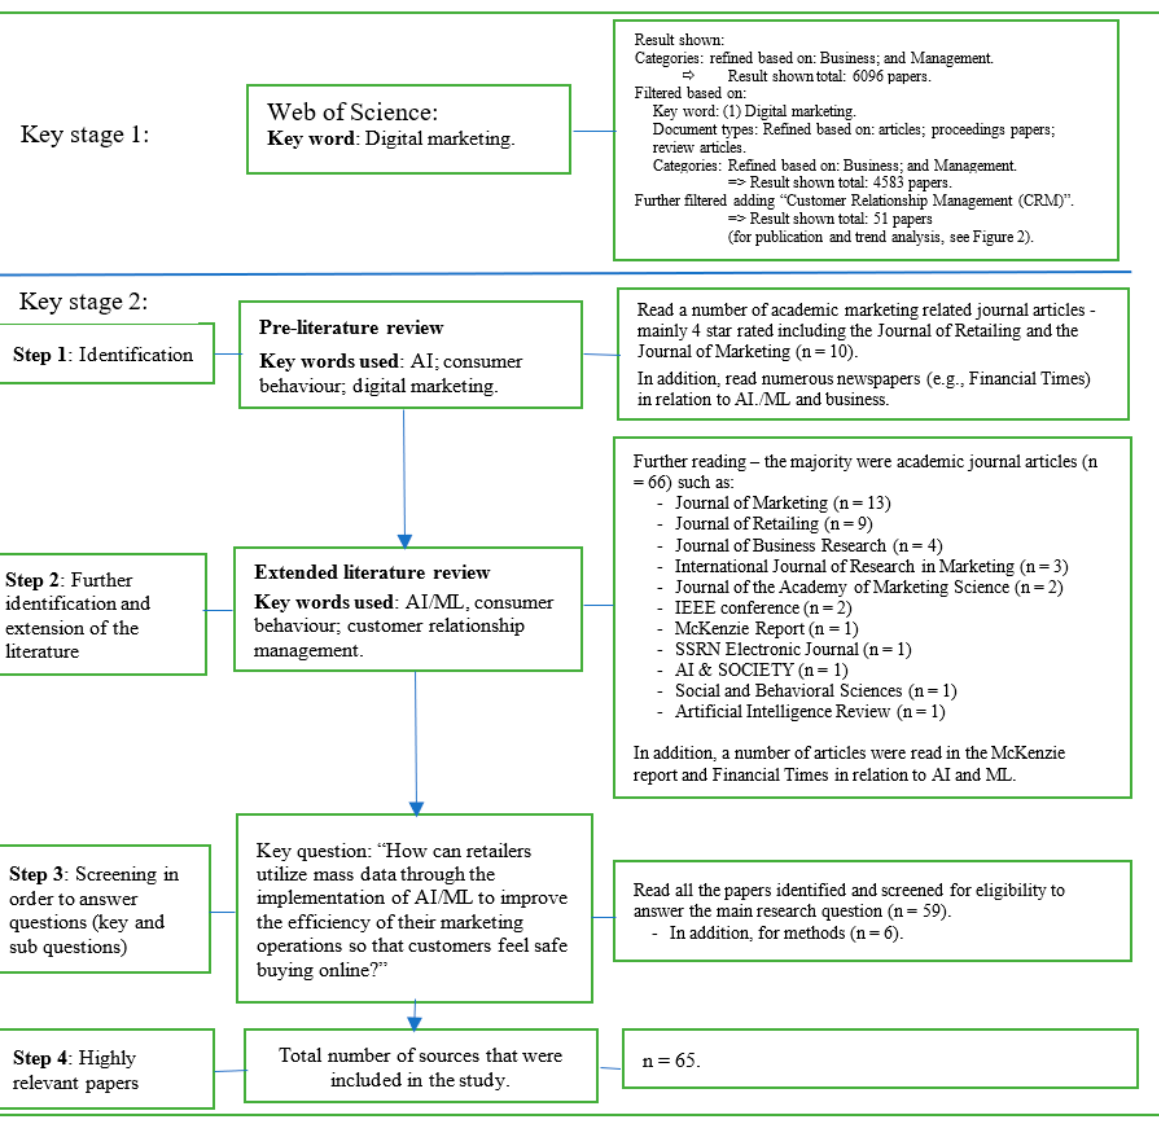
Figure 3. Main steps in the systematic literature review. Source: The authors.